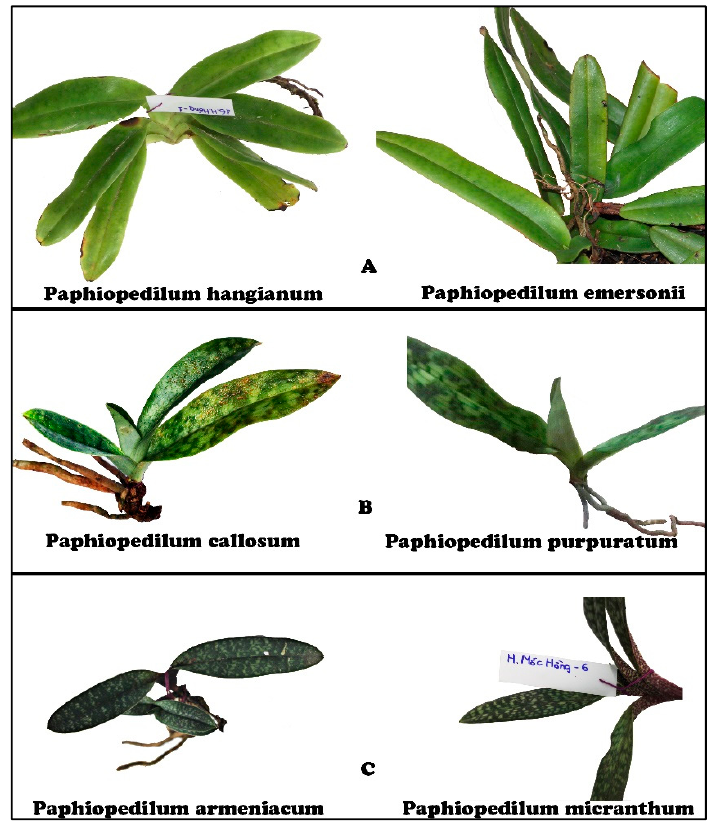
Figure 5. Similar leaf morphology in pairs of Paphiopedilum species. ( A ) P. hangianum versus P. emersonii , ( B ) P. callosum versus and P. purpuratum , ( C ) P. armeniacum versus P. micranthum.